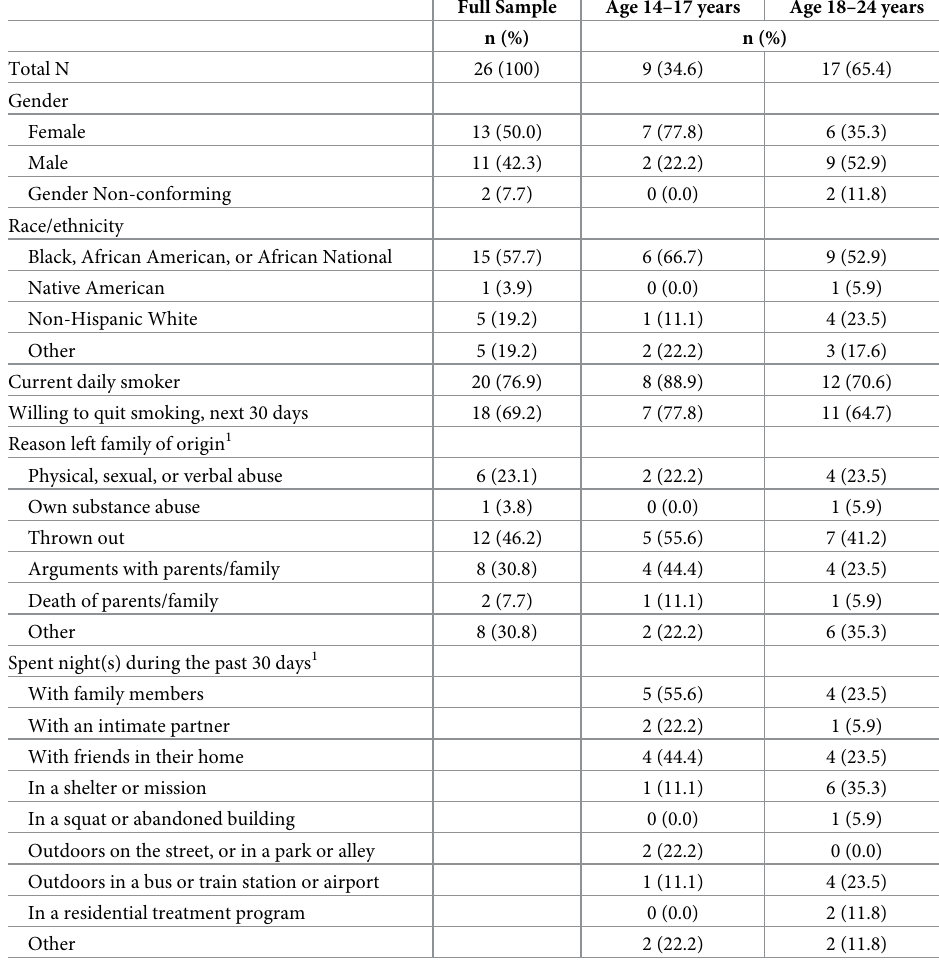
Table 2. Sample characteristics of youth experiencing homelessness who reported a smoking quit attempt and relapsed (N =